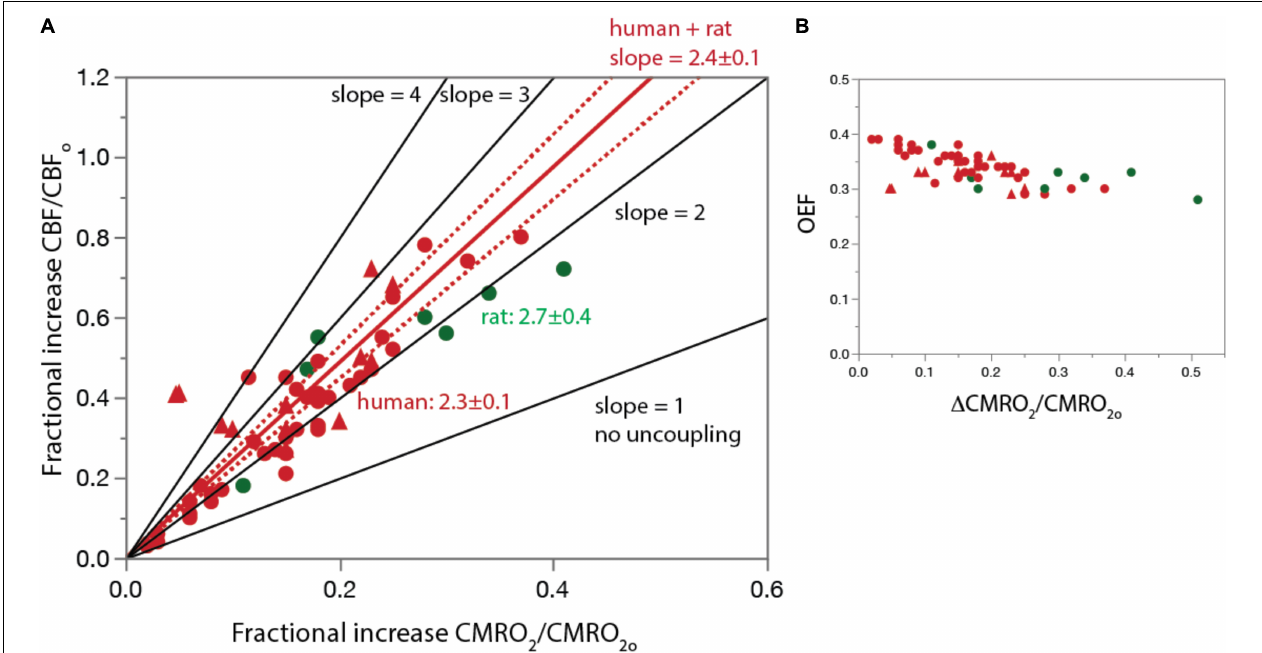
FIGURE 1 | The basis for proposing neurovascular uncoupling: rCBF increases in excess of rCMRO 2 and OEF drops upon structured stimulation. (A) Graph shows fractional increase in rCBF ( (cid:49) CBF/CBF o ) plotted as a function of the fractional increase in rCMRO 2 ( (cid:49) CMRO 2 /CMRO 2o ) in the human and rat visual cortex during photic stimulation. For comparison, lines are plotted with the predicted slope of 1 if there were no uncoupling, as well as higher slopes of 3 or 4. Human and rat data are equally well fit separately (not shown) and combined (plotted in red; dotted lines, 95% confidence interval) by linear functions of slope slightly above 2. Figure 4A is based on Figure 1 of Buxton (2010) but with additional data points. (B) OEF calculated from the same data points in A. Additional human data from Takahashi (1989), Madsen et al. (1991), Boyle et al. (1994), Marrett and Gjedde (1997), Davis et al. (1998), Vasfaee et al. (1998), Kim et al. (1999), Hoge et al. (1999), Mintun et al. (2002), Uludag et al. (2004), Ances et al. (2008), Griffeth et al. (2011, 2015), Liang et al. (2013), Germuska et al. (2019), Koush et al. (2019), and Zhang et al. (2019). Rat data from Collins et al. (1987), Ackermann and Lear (1989), Madsen et al. (1999), Dienel et al. (2002), Dienel et al. (2007), Cruz et al. (2007). All data are provided in Supplementary Table 3